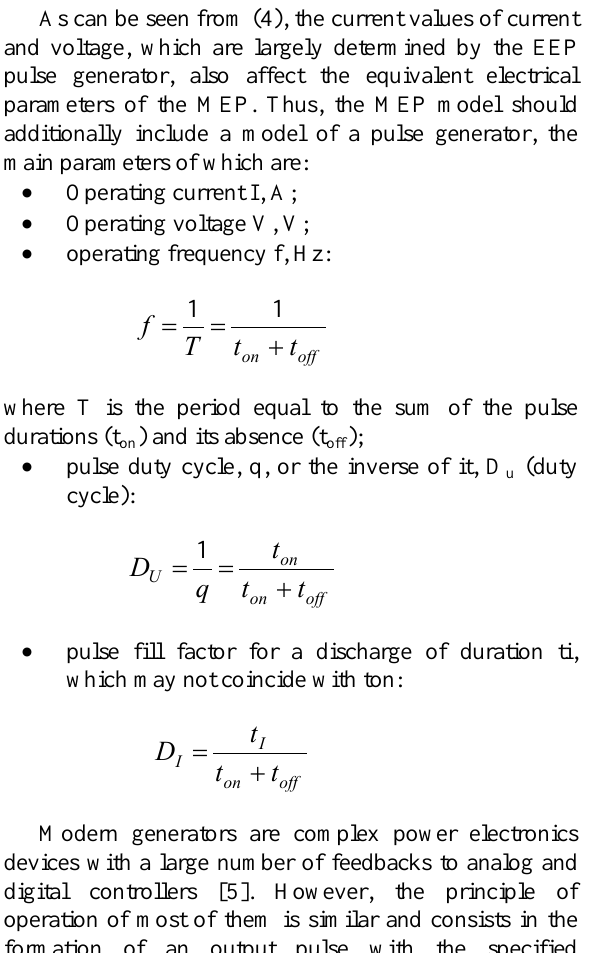
Fig. 3. The block diagram model MEP generator: voltage source (1), the control unit (2), two managed key (3), schematic model of interelectrode gap (4).